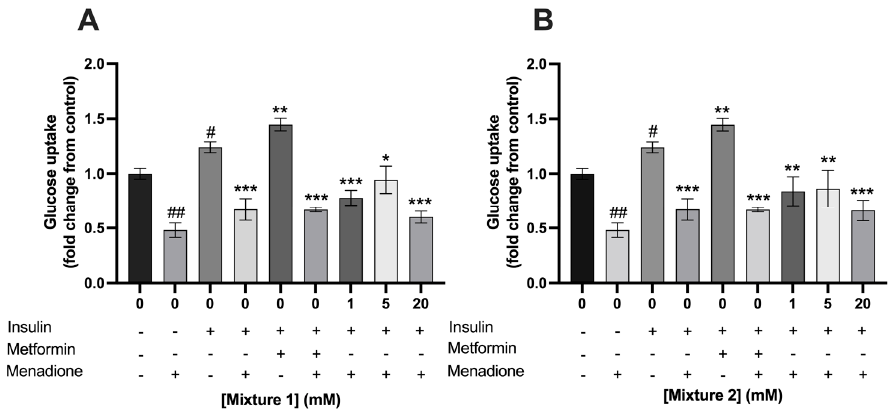
Figure 9. Exposure to a mixture of SCFAs did not prevent menadione induced reduction in glu- cose uptake in C2C12 myotubes . Exposure to mixture 1 ( A ) or mixture 2 ( B ) did not prevent menadione-induced reduction in glucose uptake in C2C12 myotubes ( N ≥ 3, n = 2). All data are presented as mean ± SEM. # p < 0.01 compared to 0 mM SCFA, ## p < 0.001 compared to 0 mM SCFA, * p < 0.05 compared to 0 mM SCFA treated with 100 nM insulin; ** p < 0.01 compared to 0 mM SCFA treated with 100 nM insulin; *** p < 0.001 compared to 0 mM SCFA treated with 100 nM insulin. Fold change was calculated from control without insulin treatment.